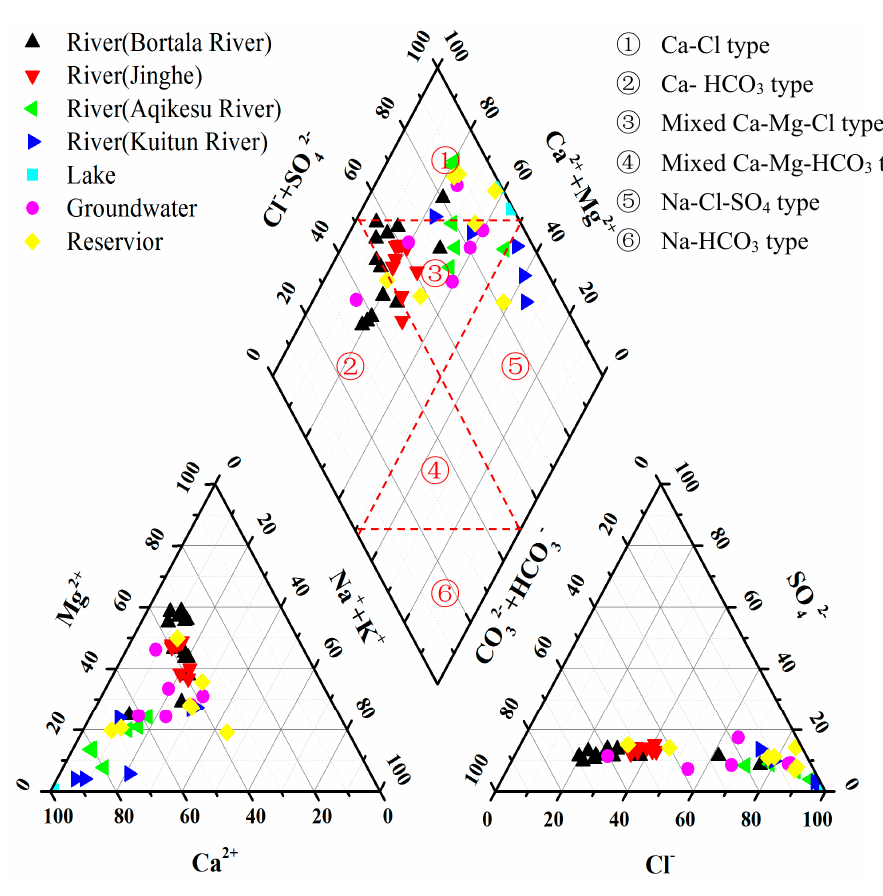
Figure 5. Piper plot of water samples.